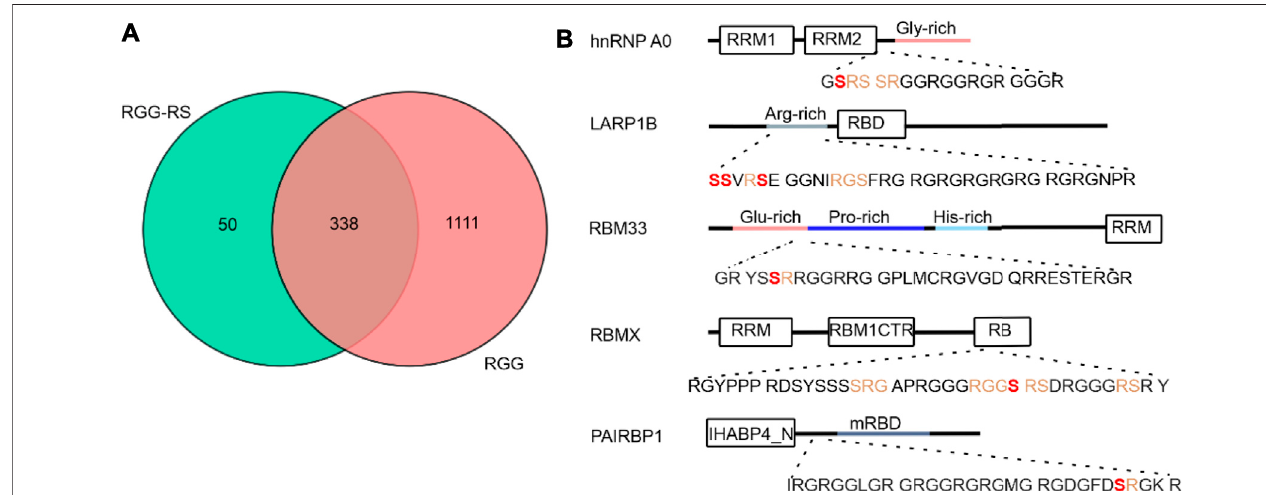
FIGURE 5 | Analysis of distribution of coexisting RG/RGG and RS/SR regions in human proteome. (A) Venn diagram corresponding to the PROSITE analysis (https://prosite.expasy.org/scanprosite/) of two motifs from protein sequences database fi ltered for human proteins (taxid:9606) harboring either 1) a di-RG motif (pink) eachspacedbyzeroto fi veaminoacids[R-G-x(0-5)-R-G]or2)adi-RGmotifinthepresenceofRSorSRinthemiddle,afterorbeforedi-RGmotif(blue)spacedbyzeroto fi ve residues [R-G-x(0,5)-R-G-x(0,5)-R/S], [R/S-x(0,5)-R-G-x(0,5)-R-G] and [R-G-x(0,5)-R/S-x(0,5)-R-G]. These two groups of proteins were compared with each other in the Venn diagram. (B) Domain organization of fi ve putative human proteins possessing RS/SR motifs within or next to the RG/RGG region; architectural representation was performed according to InterPro (https://www.ebi.ac.uk/interpro/protein/) and Uniprot (https://www.uniprot.org/) databases. RS/SR motifs located in the proximity to RG/RGG regions are shown in orange, and serine residues that are reported to carry phosphorylation (according to iPTM and PhosphoSitePlus) are illustrated in bold (red). Abbreviations used: hnRNP A0 - heterogeneous nuclear ribonucleoprotein A0; RRM – RNA recognition motif; LARP1B- La ribonucleoprotein domain family member 1B; RBD - HTH La-type RNA-binding domain; RBM33 - RNA-binding protein 33 (drawn not in a scale); RBMX - RNA-binding motif protein, X chromosome; RBM1CTR - C-terminal region present in RBM1-like RNA binding hnRNPs; RB- region necessary for RNA-binding; PAIRBP1 - plasminogen